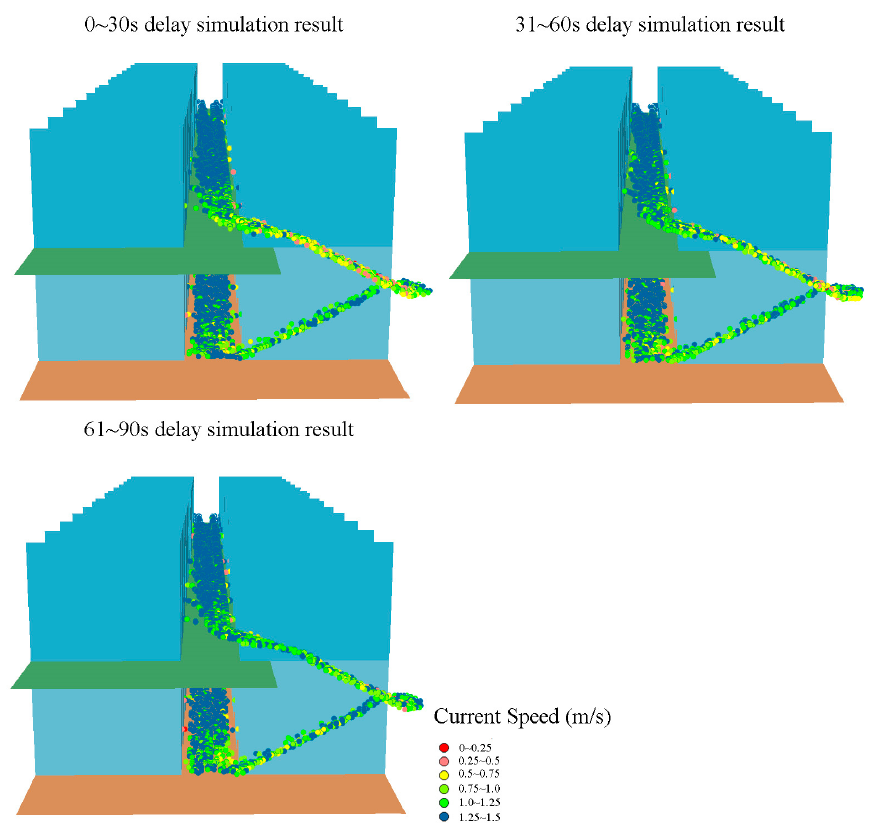
Figure 9. The spatial distribution of accumulated personnel real-time speed under different delay times.